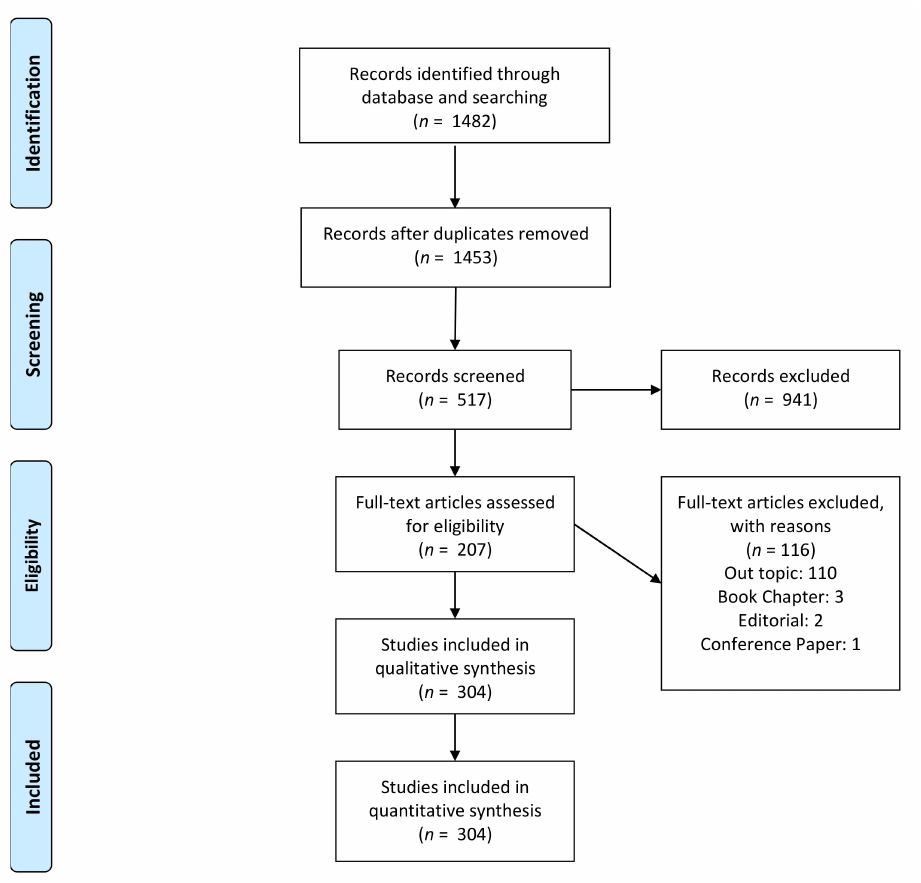
Figure 1. PRISMA flowchart of the included